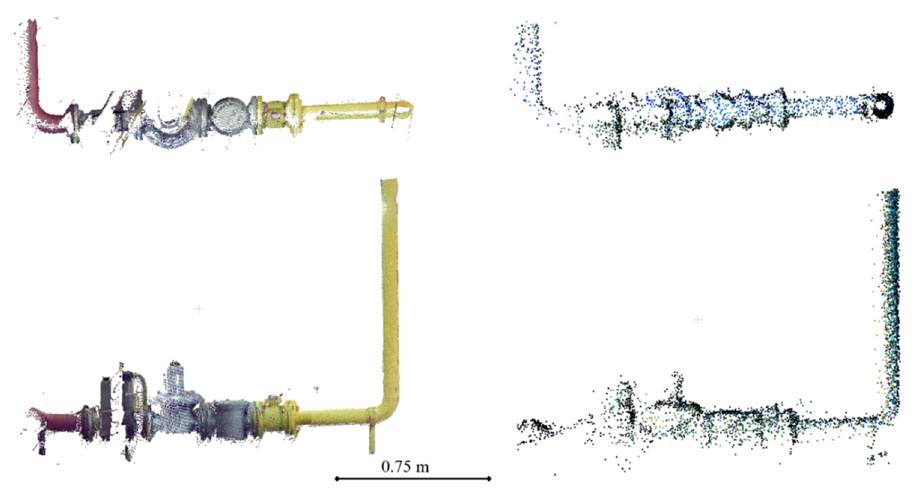
Figure 9. Example of points clouds of the pressure regulation system located at the entrance of the gas in the boilers obtained with Faro (Left) and with Zeb-Revo (Right).